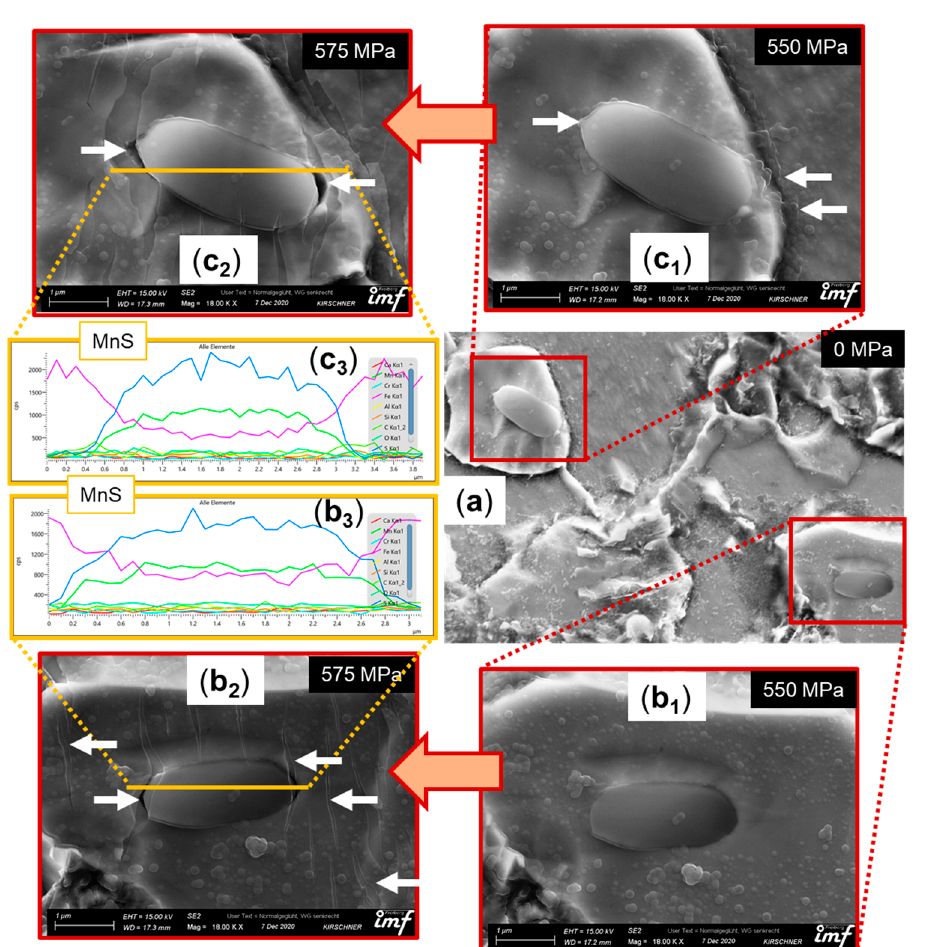
Figure 14. ( a ) Localized single inclusion identification, ( b ) represents an elliptical inclusion parallel to the applied load at 550 MPa and 575 MPa, respectively. ( c ) represents an elliptical inclusion placed 30 degree to the applied load at 550 MPa and 575 MPa, respectively. EDS show the maximum concentration of manganese and sulfur along the measured length verifying both to be an MnS inclusions. The white arrows point to the local damage initiation and growth.